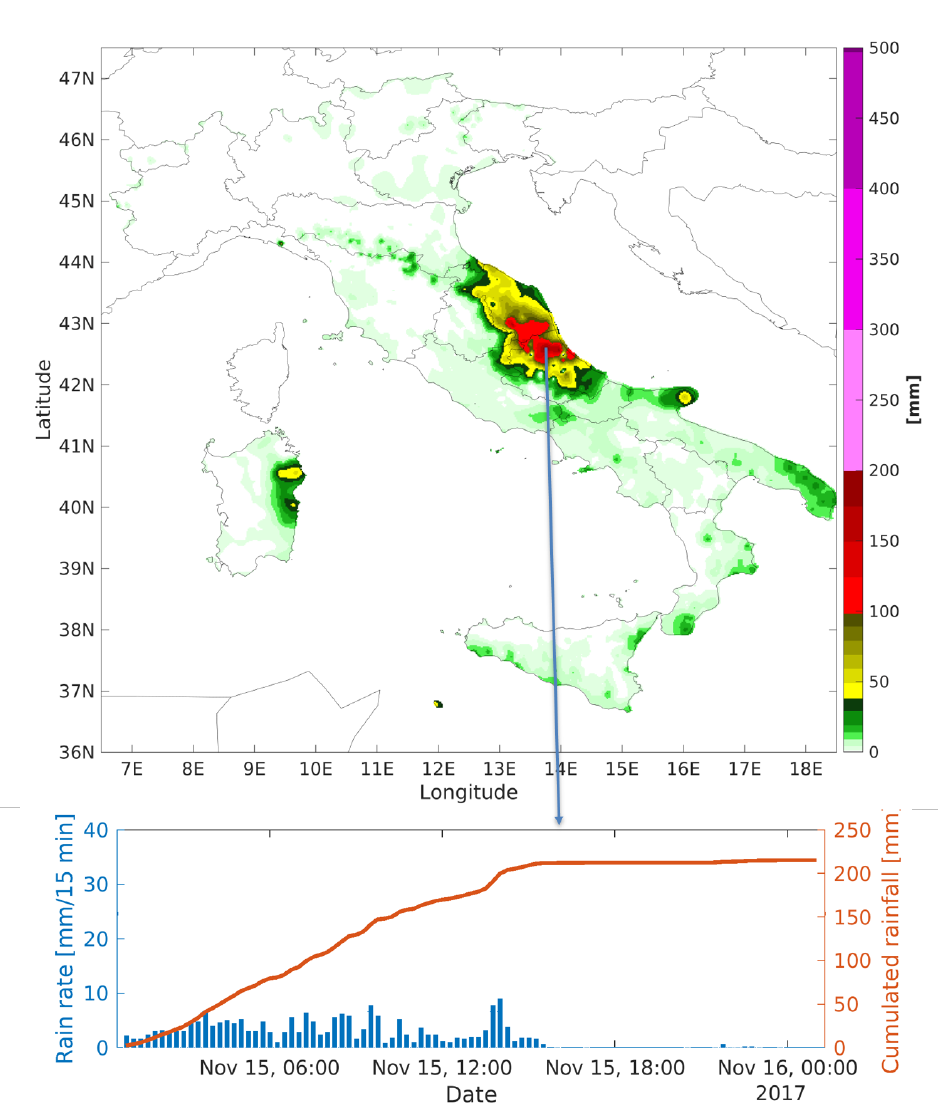
Figure 2. Quantitative Precipitation Estimate (QPE) 24 h on 15 November 2017 ( upper panel ) and raingauge observation during the same hours over the area of interest ( lower panel , courtesy of the Italian Civil Protection